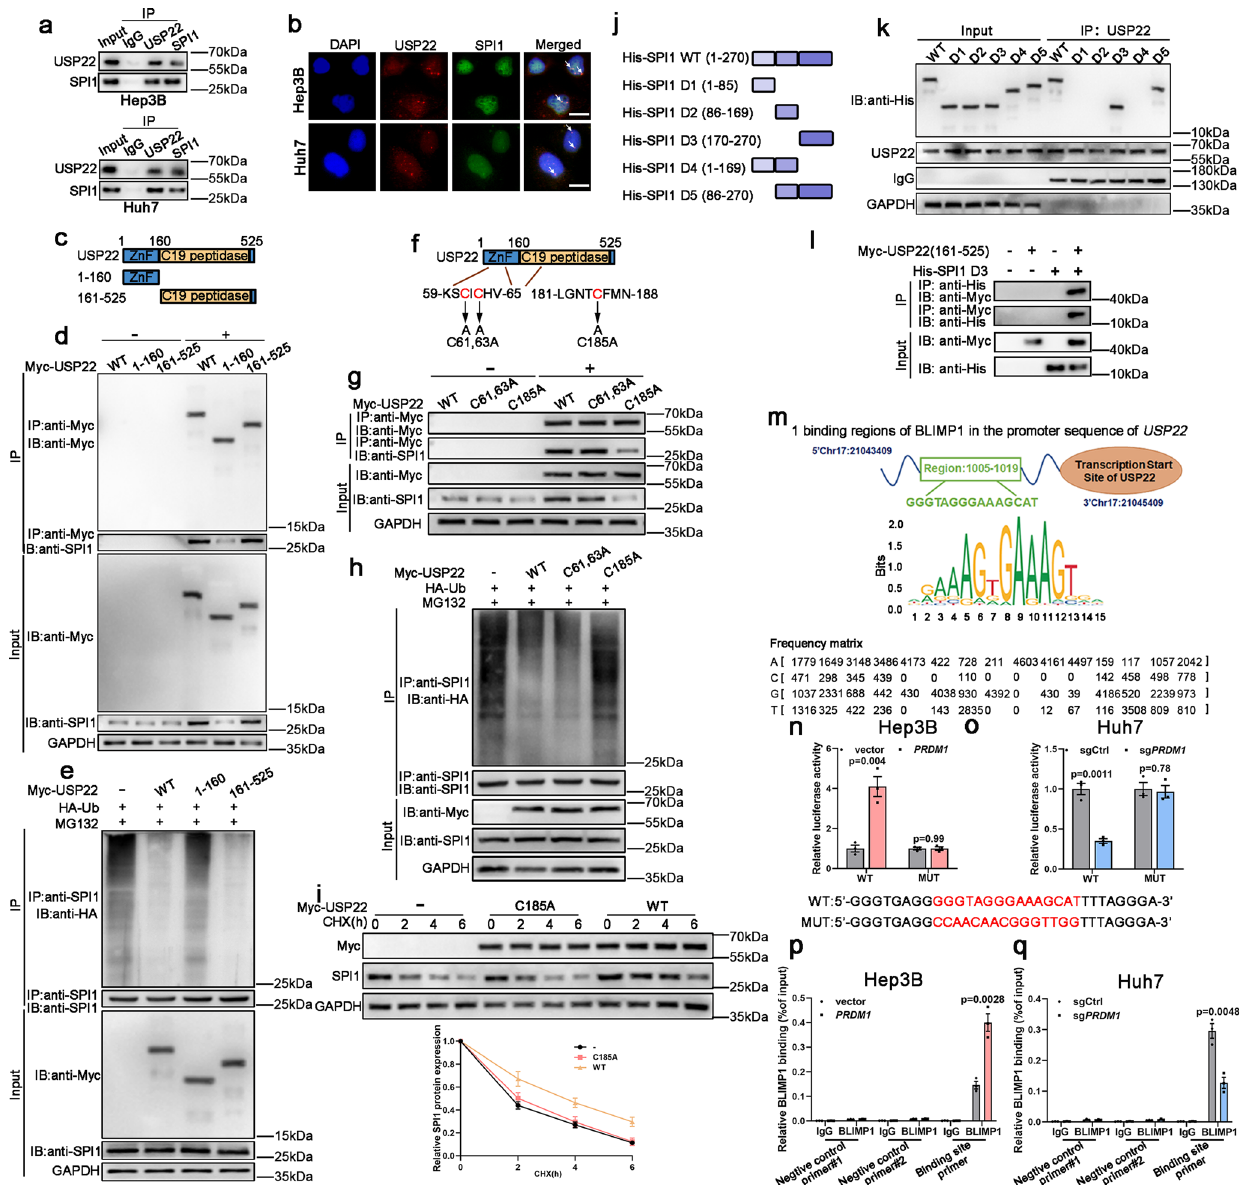
Fig. 5 | USP22 was identi fi ed as a SPI1-interacting protein. a Co-IP experiments indicated the interaction of endogenous USP22 and SPI1. n =3 independent bio- logical replicates. b Confocal microscopy showing colocalization of USP22 (red) with SPI1 (green). n =3 independent biological replicates. Scale bars, 20 µ m. c Schematic illustration of USP22 and its mutants. d USP22 and its mutants were immunoprecipitated and the bound SPI1 was determined. n =3 independent bio- logical replicates. e SPI1 ubiquitination was determined by SPI1 immunoprecipita- tion and western blotting using an anti-HA antibody. n =3 independent biological replicates. f Schematic illustration of USP22 and its point mutants. g USP22 and its pointmutantswereimmunoprecipitatedandtheboundSPI1wasdetermined. n =3 independent biologicalreplicates. h The effectsofUSP22 and its point mutants on SPI1 ubiquitination were con fi rmed. n =3 independent biological replicates. i